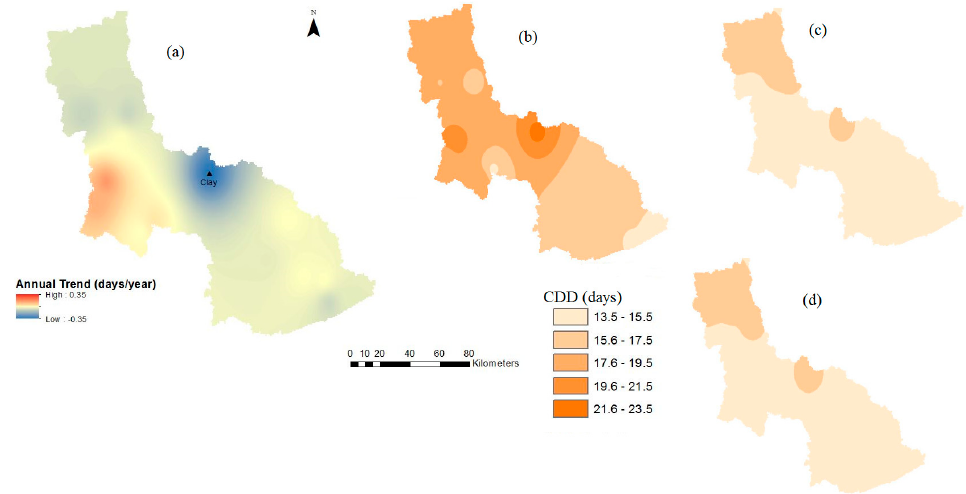
Figure 6. Spatial distribution of CDD ( a ) trend and mean values under: ( b ) baseline; ( c ) late ‐ century RCP 4.5; and ( d ) late ‐ century RCP 8.5, in the Kentucky River Basin. Filled triangles indicate a statistically significant ( p < 0.05) trend.